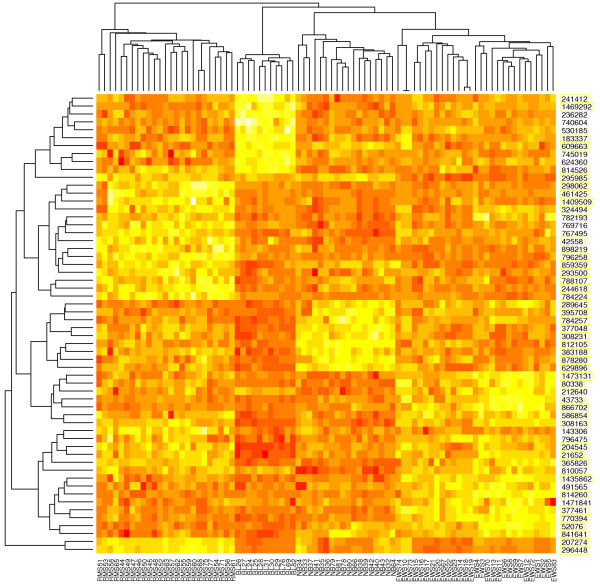
Clustering dendrogram of SRBCT data – First Iteration.